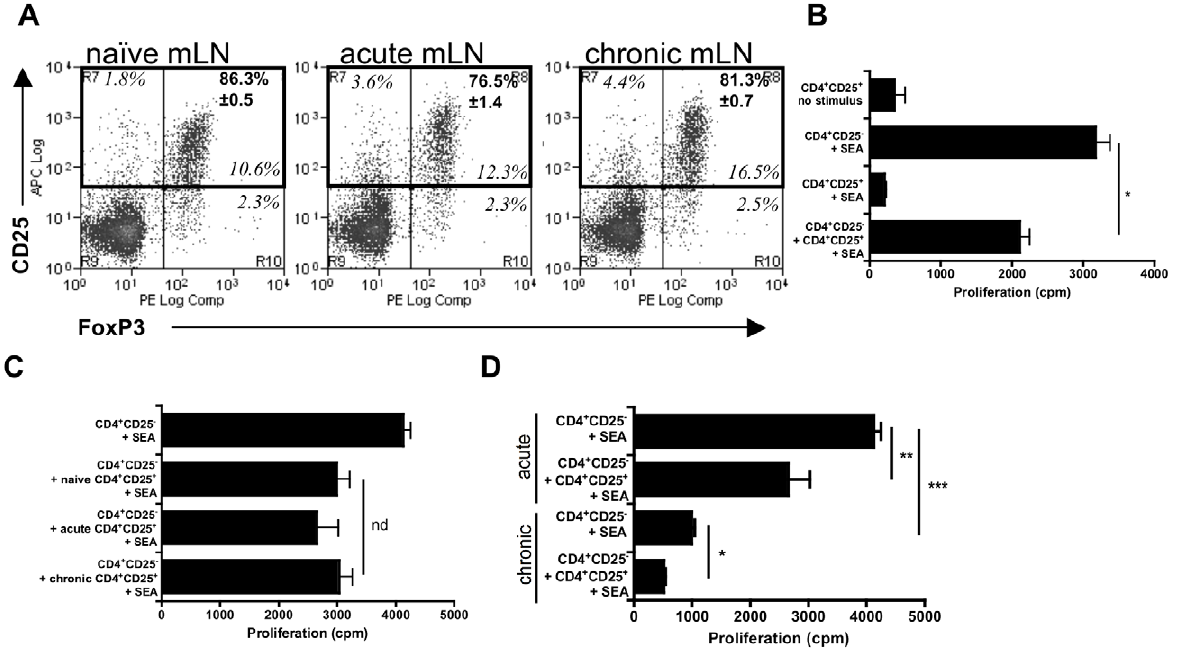
Figure 4. CD4 + CD25 + mLN cells suppress antigen-specific CD4 + Th2 responses invitro. A ) Flow plots of mLN cell suspensions (n=3 mice) labelled with anti-CD25 and anti-FoxP3, gated on CD4 expression. Values in italics are quadrant percentages. Values in bold, upper right-hand quadrant, are mean ( 6 SEM) CD4 + CD25 + FoxP3 + cells as a % of total CD4 + CD25 + cells (relevant quadrants outlined in bold). B ) Antigen-specific proliferation of CD4 + CD25 - effector cells from acute mice and CD4 + CD25 + T regs from chronic mice, or co-cultured together in a 2:1 ratio. C ) Co-culture of CD4 + CD25 - effector cells derived from acute mice cultured with CD4 + CD25 + T regs derived from naı¨ve, acute or chronic mice. D ) CD4 + CD25 - effector cells from mice with an acute or chronic infection, either depleted of CD4 + CD25 + cells, or with CD4 + CD25 + cell ‘add-back’ co-cultures from the same stage of infection at a 2:1 ratio. All histograms are mean ( 6 SEM) cpm 3 H-thymidine incorporation.